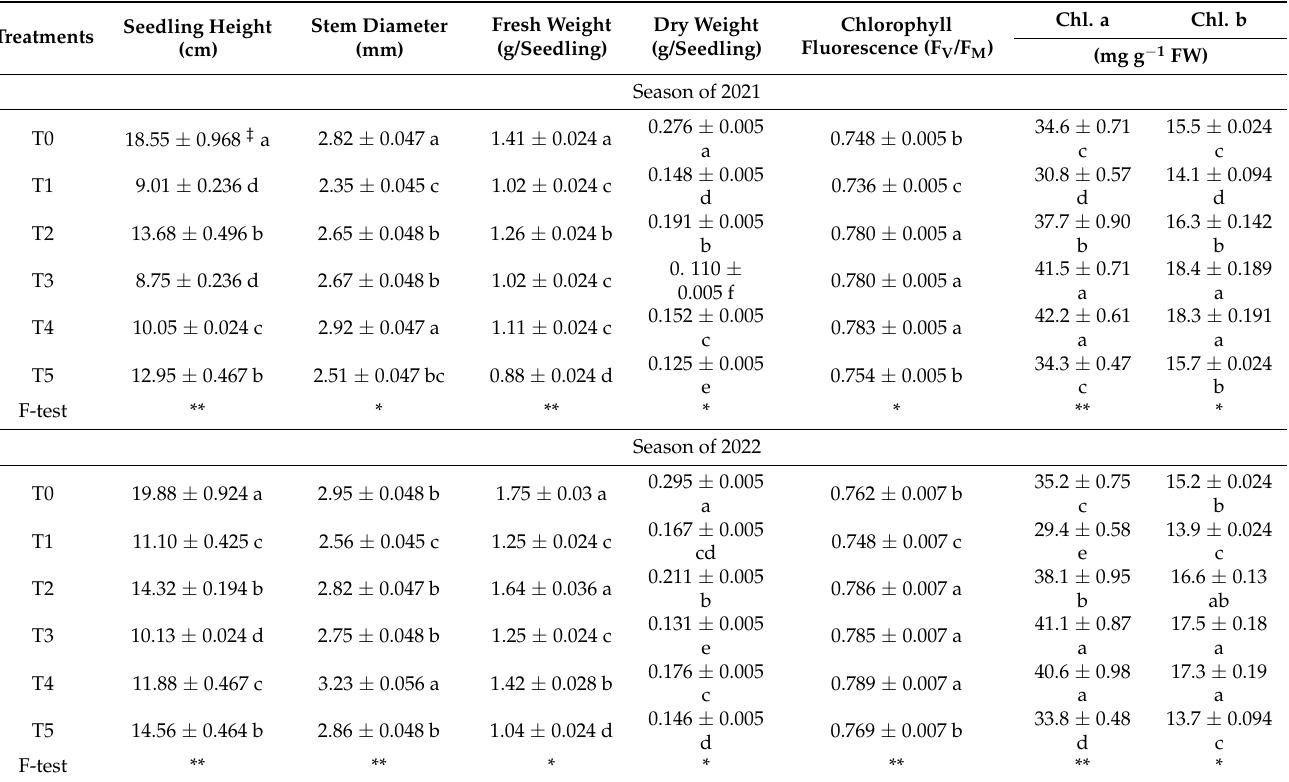
Table 7. Some vegetative growth parameters and chlorophyll fluorescence and content as influenced by treatments at 30 days after sowing date during both